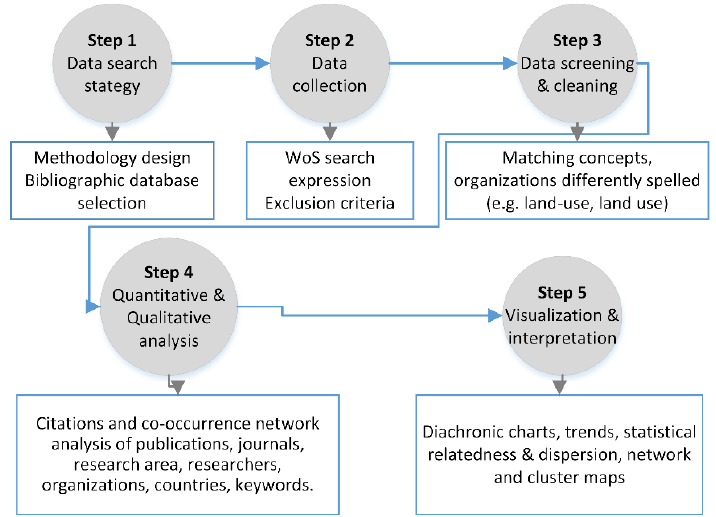
Figure 1. Bibliometric and systematic literature review workflow.